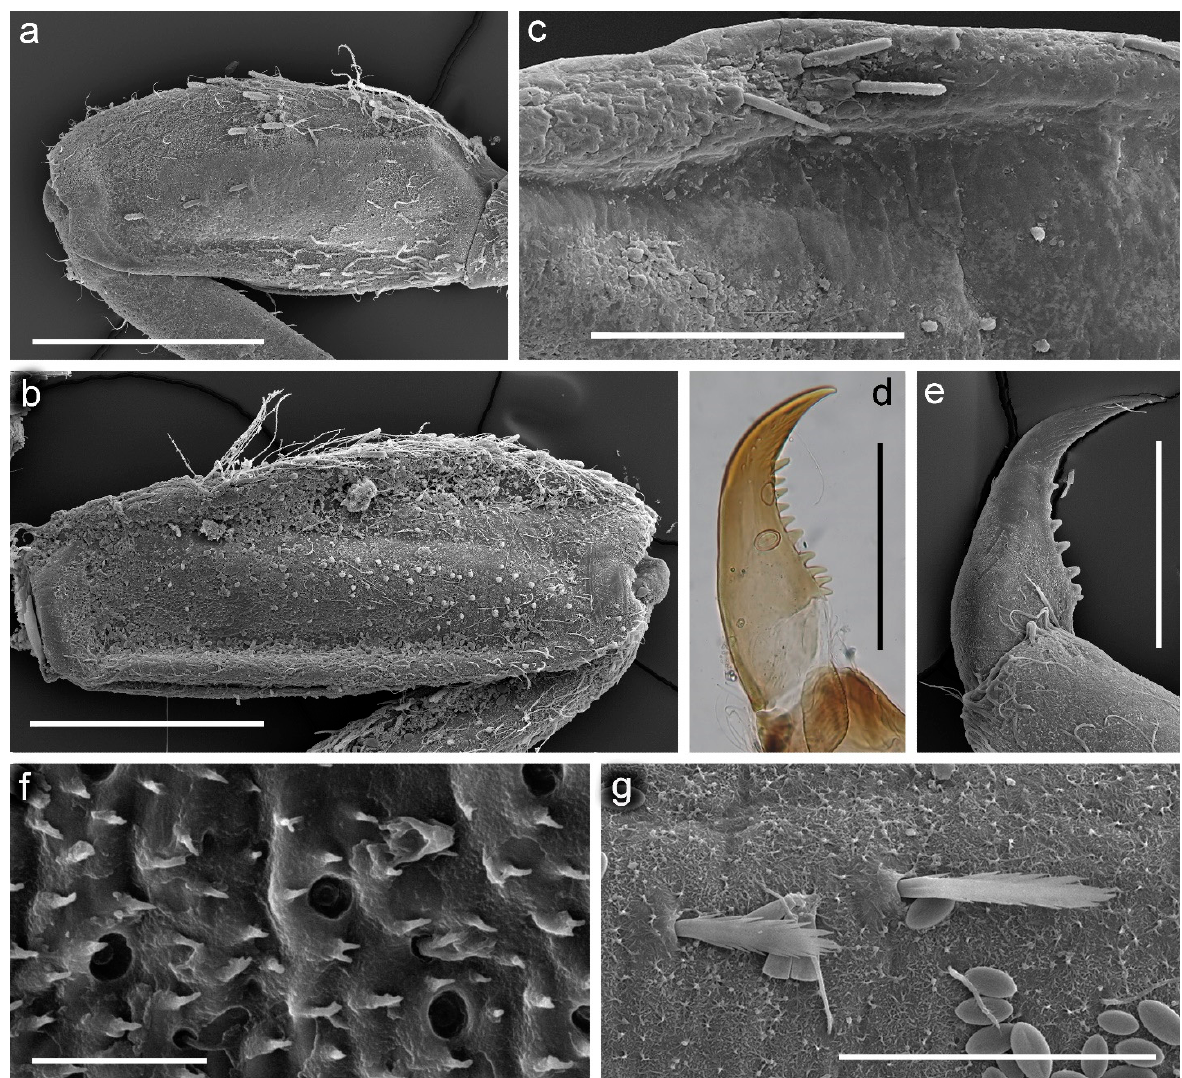
Figure 9. Larva of Torleya elissa (Jacobus, Zhou & McCafferty, 2009). ( a ) fore femur, ( b ) middle femur, ( c ) group of stout setae on fore femur, ( d , e ) tarsal claws, ( f ) dorsal surface of femur, ( g ) setae on dorsal surface of hind tibia. Scale bars: ( a , b )—0.5 mm, ( c )—0.25 mm, ( d , e )—0.2 mm, ( f )—0.02 mm, ( g )—0.1 mm.